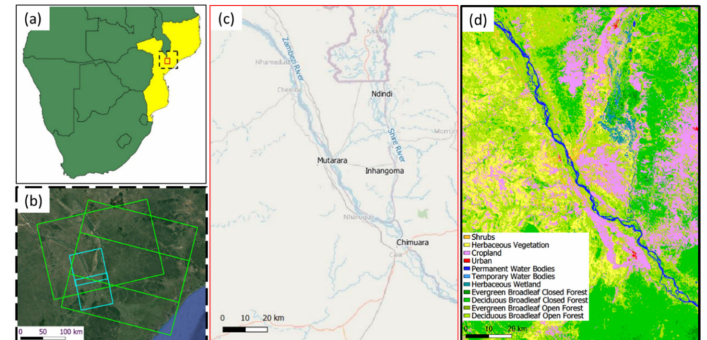
Figure 1. ( a ) Location of the Zambezi River basin, ( b ) enlarged view with footprints of the Satellite imagery—green: Sentinel-1 (ascending and descending), cyan: ALOS 2, (2 frames); ( c ) detail map with locations and toponyms described in the text; ( d ) CORINE land cover map for the region of interest, with